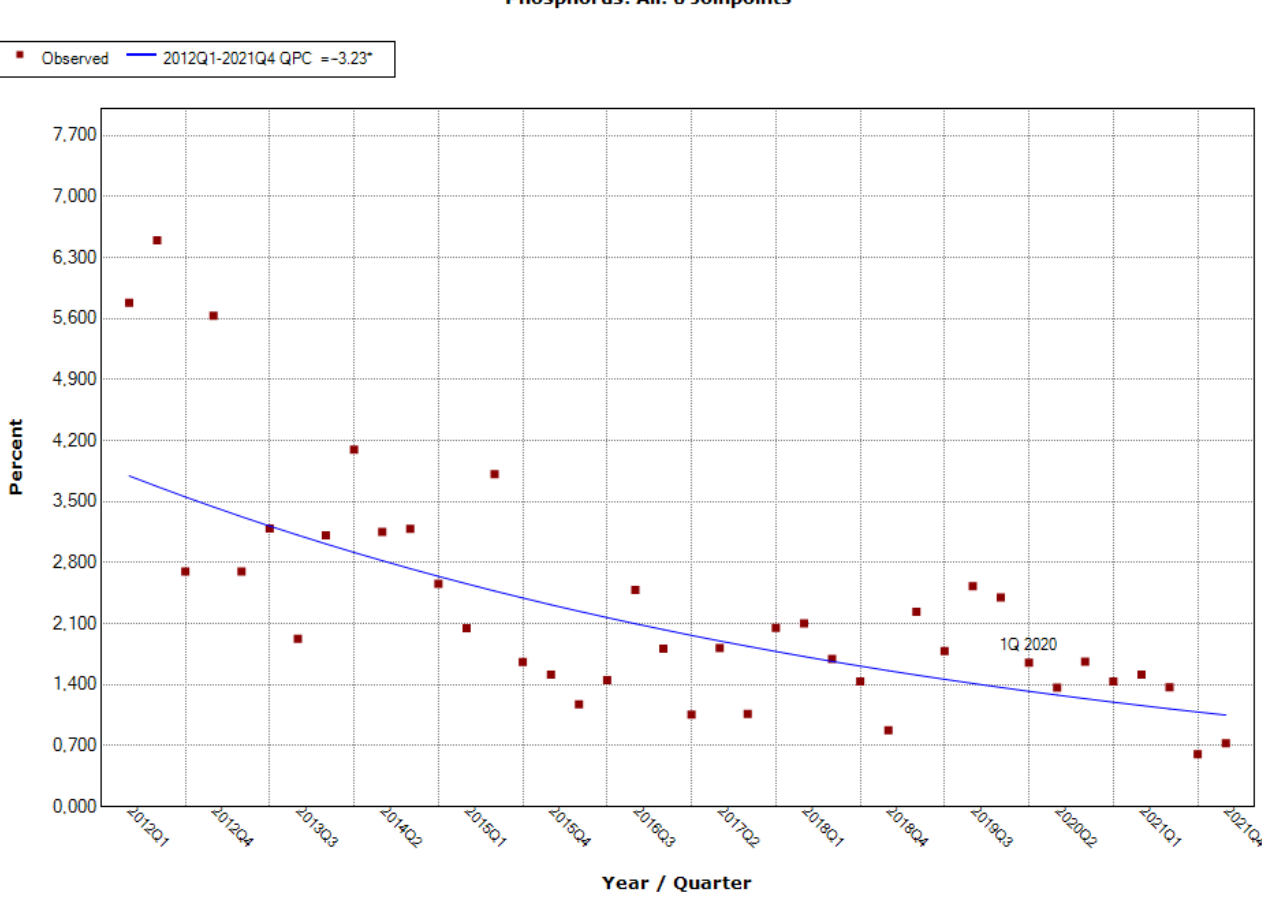
Figure A13. Percentage of products containing phosphorus in individual quarters in the period from 2012 to 28 November 2021. Joinpoints mark trend turning points. The date above the observation indicates the moment of publication of the scientific opinion/resolution.